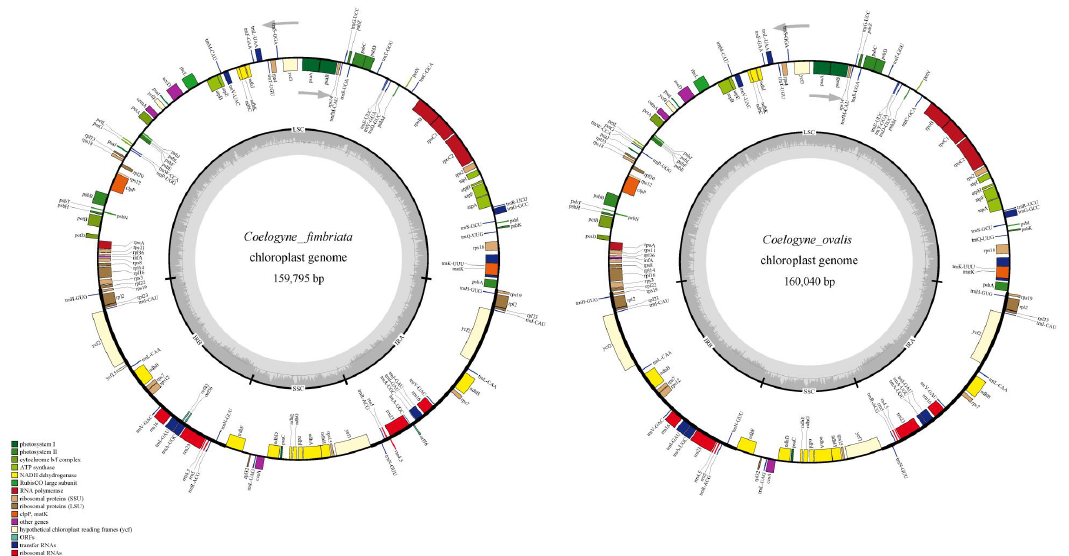
Figure 1. Physical maps of the complete chloroplast genomes in Coelogyne fimbriata and Coelogyne ovalis . The inner circle’s genes are transcribed in the clockwise direction, while outside genes are counterclockwise. The areas with light and dark gray coloration in the internal circle suggest guanine-cytosine (GC) content of its